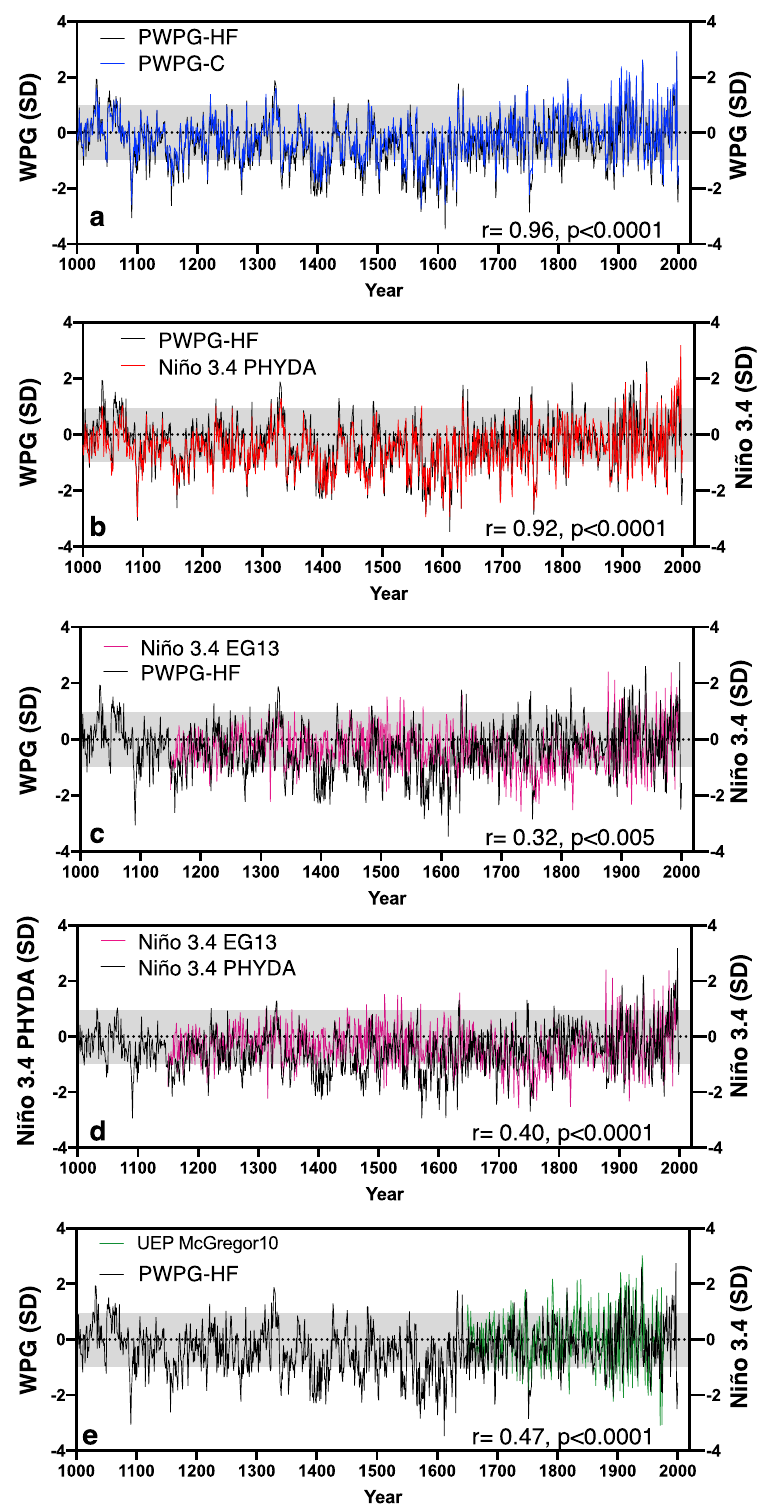
Figure 3. Mean annual reconstruction of the WPG from the Last Millennium PHYDA 34 multivariate proxy network. Time series were normalised relative to 1961–1990 (SD = standard deviation). WPG based on Hoell and Funk 24 (black line) with one standard deviation (SD; grey bar) threshold compared to ( a ) WPG based on definition of Cai et al. 25 (blue), both calculated from PHYDA, ( b ) PHYDA-based Niño3.4 index (red line), ( c ) Niño3.4 reconstruction (magenta line; EG13) of Emile- Geay et al. 22 , ( d ) 34 PHYDA-based Niño3.4 index (black line) compared to Niño3.4 reconstruction (magenta line; EG13) of Emile-Geay et al. 22 and ( e ) the WPG based on Hoell and Funk 24 (black line) compared to the Niño3.4 reconstruction (green line; McGregor10) of McGregor et al. 18 . Correlation coefficients (year to year) are indicated over full period of overlap for detrended